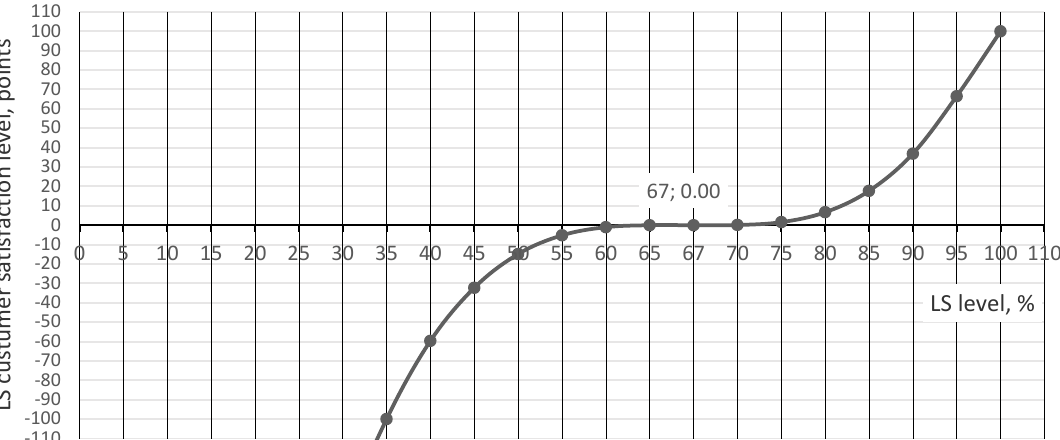
Figure 1. The dependence of the level of consumer to satisfaction execution of orders from logistics services company